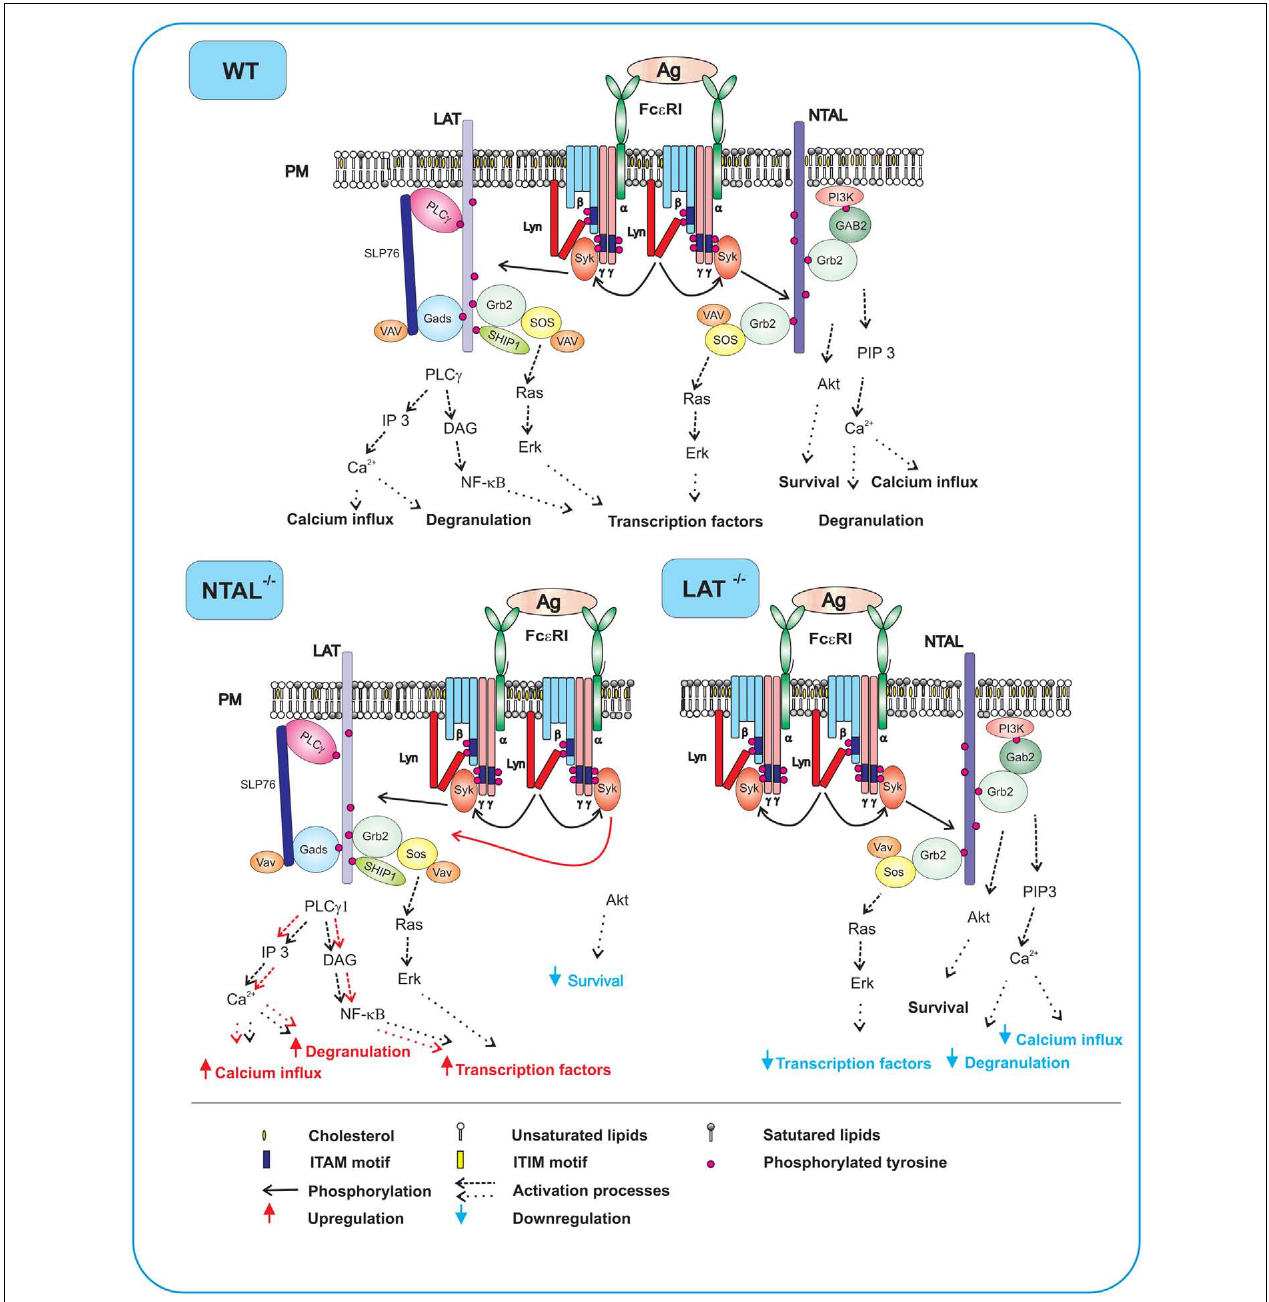
FIGURE 2 | Fc ε RI signaling events inWT, NTAL − / − , and LAT − / − cells. In WT cells expressing both NTAL and LAT, aggregation of the receptors by multivalent antigen leads to rapid Lyn kinase-mediated phosphorylation of tyrosine residues in ITAM motifs of Fc ε RI β and γ subunits, followed by anchor of Syk to Fc ε RI through interaction of Syk SH2 domains with phosphorylated ITAMs. Syk then phosphorylates NTAL and LAT to create binding sites for various SH2-containing proteins. Phosphorylated LAT allows direct binding of SH2 domains of PLC γ 1, Grb2, Gads, and SHIP1. Grb2 and Gads serve as binding sites and stabilizers for other molecules including SLP-76,VAV, and SOS. Activity of PLC γ 1 leads to enhanced production of IP3 and DAG, followed by increased Ca 2 + influx, degranulation, and production of transcription factors. Phosphorylated NTAL also binds